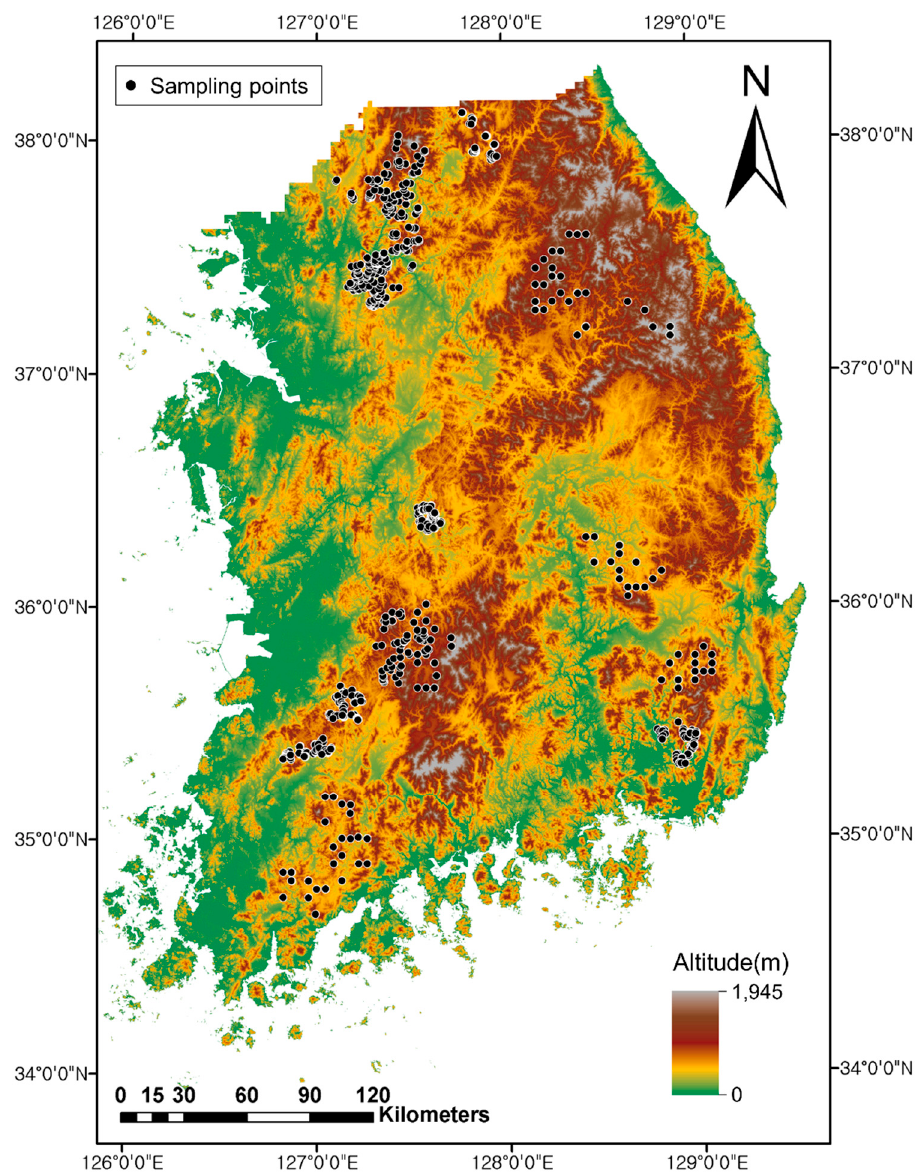
Figure 1. Distribution of collected forest soils in South Korea (1456 soil samples).